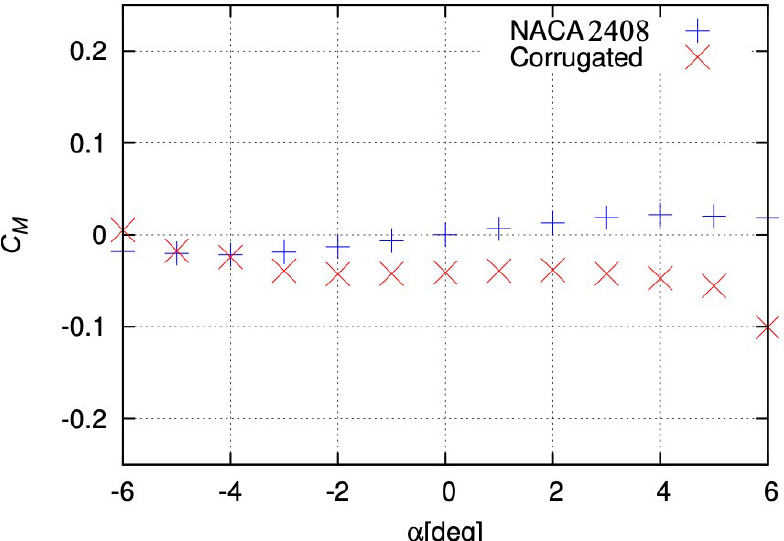
Figure 21. The mean static moment coefficient of the corrugated airfoil and the profiled NACA2408 airfoil at Re = 4000 with varying angle of